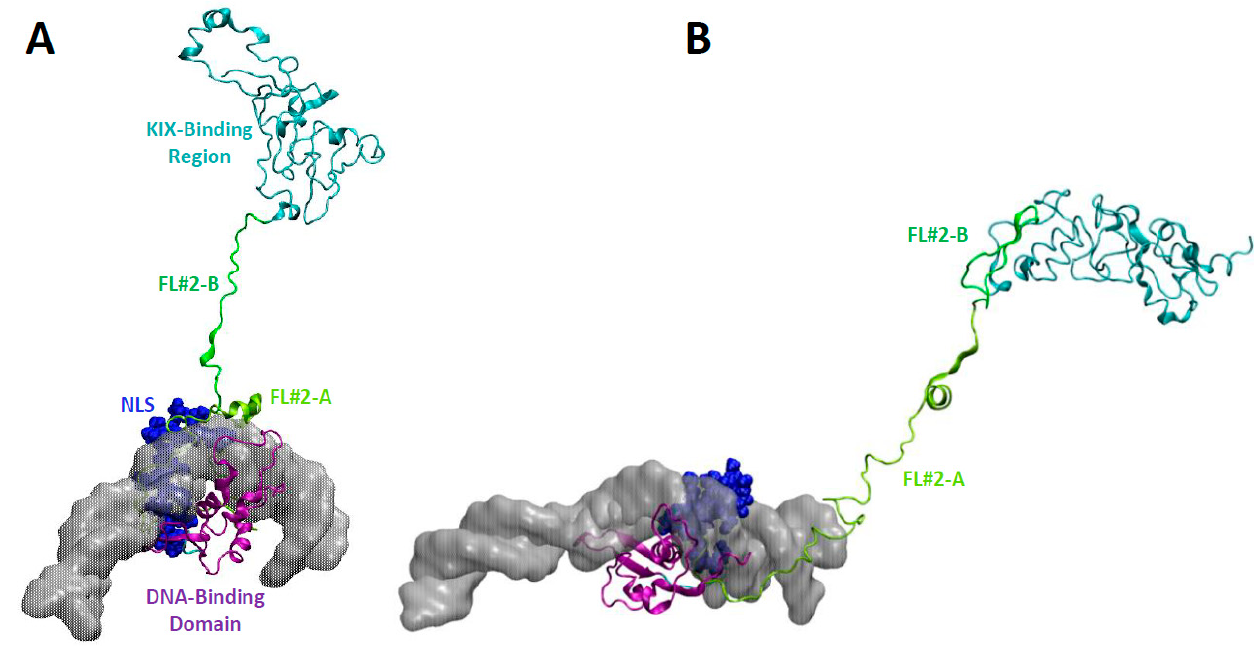
Figure 4. Stretched linker regions emanating from the DNA-binding and nuclear localization sequence (NLS). The DNA- binding domain is shown in a purple cartoon structure bound to DNA represented as a semitransparent surface. The NLS is shown in dark blue as van der Waals spheres. The first part of Flexible Linker #2 (FOXO3 260 − 321 ; FL#2-A) is shown as a lime-green cartoon structure, the second part (FOXO3 322 − 344 ; FL#2-B) in green. The KIX-Binding Region (FOXO3 433 − 508 ) is represented as a cyan cartoon structure. ( A ) FL#2-A folds partially in a helical conformation and remains mostly associated with DNA (FL#2-A compact conformation). FL#2-B is highly extended. ( B ) FL#2-A is present in an extended conformation (FL#2-A extended conformation) and FL#2-B is mostly folded onto the KIX-Binding Region.